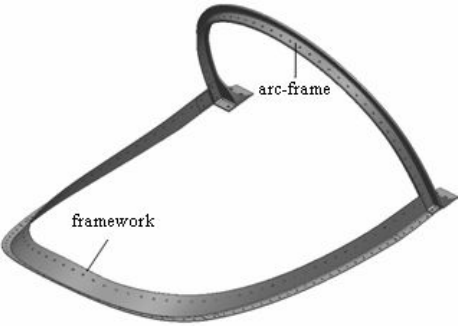
Fig. 3. The framework and arc-frame in UG